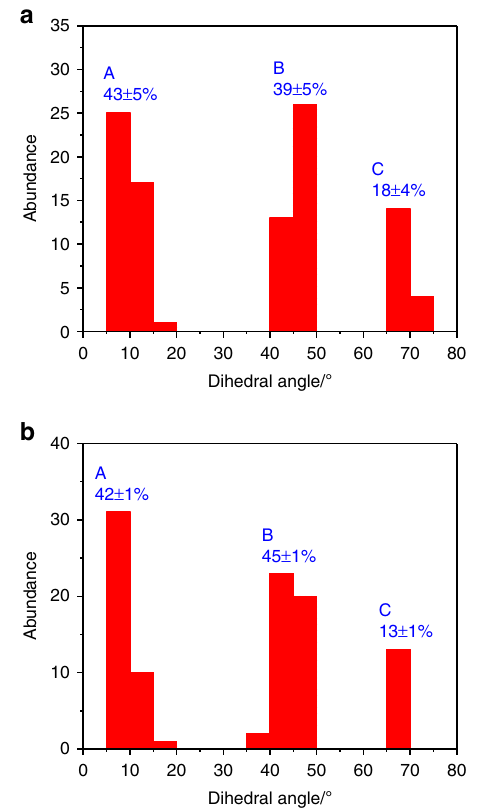
Figure 4 | Comparison of experimental and calculated distributions of docking complexes formed between MP and NEA on Pd(111). The figure displays histograms showing the proportions of ( a ) experimentally measured and ( b ) calculated abundances versus the dihedral angles between the naphthyl ring of NEA and the long axis of MP. The results reveal that the complexes fall into three, well-defined bins defined by a range of dihedral angles; A; 10 ± 5 (cid:2) , B; 45 ± 5 (cid:2) and C; 70 ± 5 (cid:2)